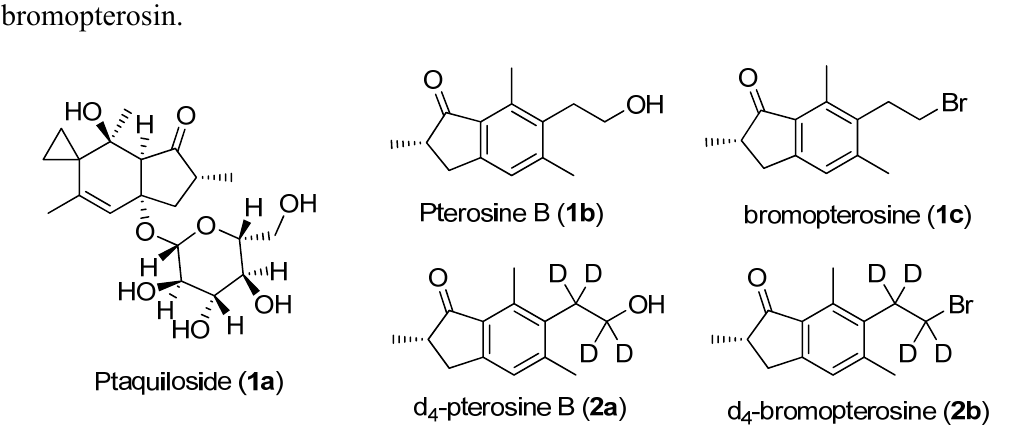
-pterosin B, and 4